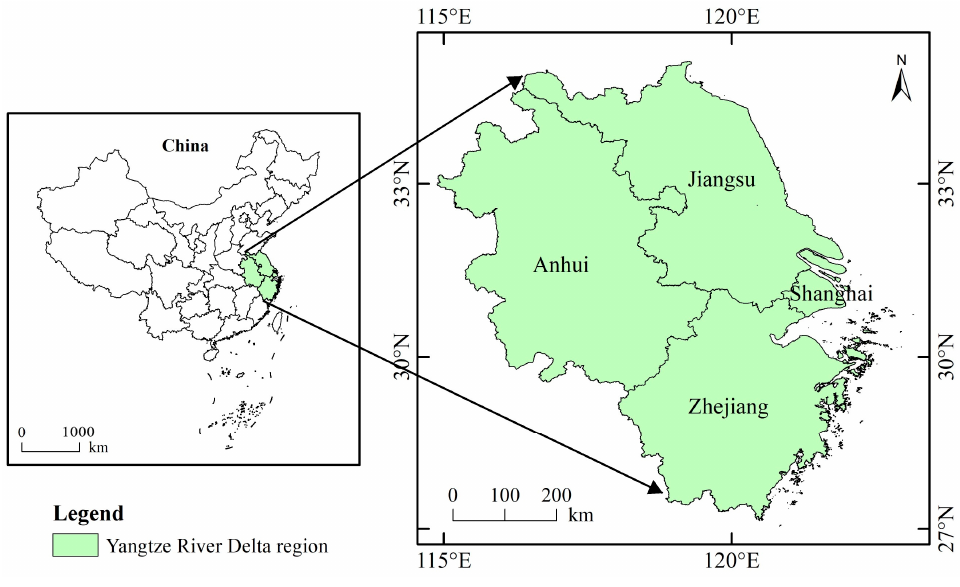
Figure 3. Case study area.